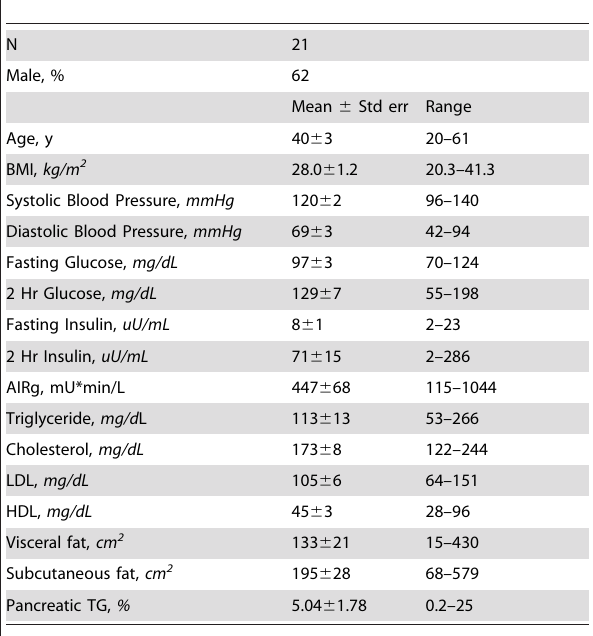
Table 1. General characteristics, metabolic variables, and abdominal and pancreatic fat distribution of study